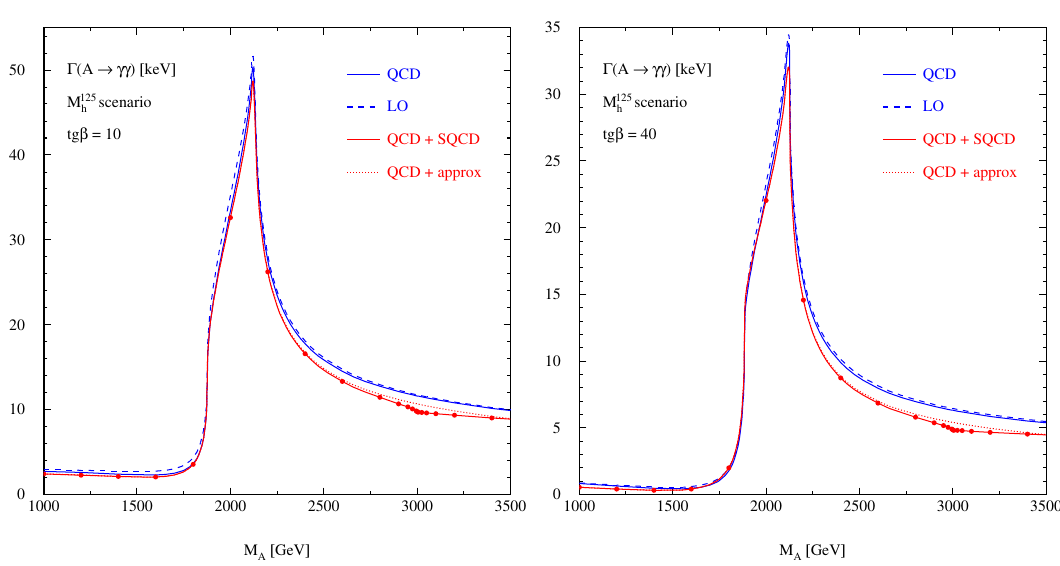
Figure 15 . The partial decay width of A → γγ for two values of tg β = 10 , 40 in the M 125 benchmark scenario at LO and NLO QCD (blue) and including the genuine SUSY-QCD corrections involving effective Yukawa couplings